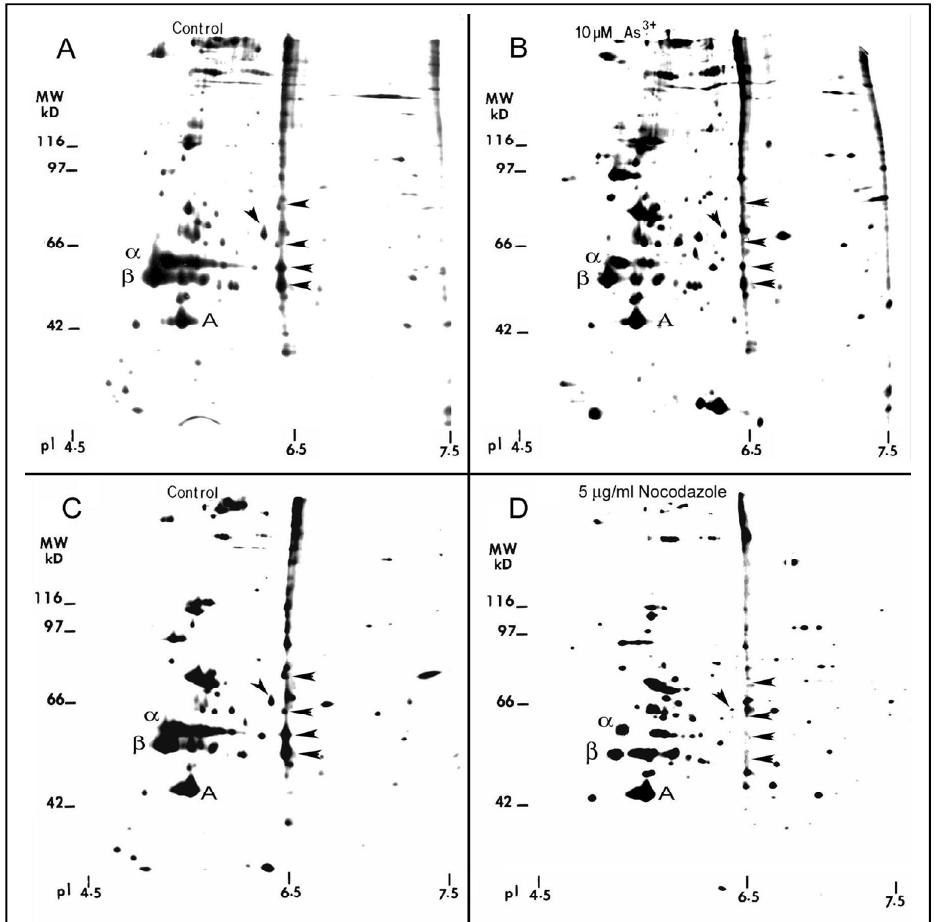
Figure 10. 2-D gel profile of tubulins, MAPs, and other cytoskeletal proteins in As 3+ -treated cells. Growth-arrested RFL6 cells were labeled with [ 35 S]methionine (50  Ci/mL) in the absence ( A ) or presence ( B ) of 10 µM As 3+ for 24 h. Cells treated without ( C ) or with ( D ) 5 µg/mL nocodazole, an MT depolymerization agent, at the last 3 h of the metabolic labeling, were used as a positive control. The MT protein-rich extracts with identical redioactivity from control and treated cells were processed for 2-D gel analysis ( α , β and A indicate α tubulin, β tubulin and actin, respectively). For MAP nomenclature, e.g., MAP56/6.5, the numbers refer to their apparent molecular weight (MW in kDa) and isoelectric point (pI), respectively. Protein quantitation was measured by the 1 D Scan EX software. Arrowheads indicate altered